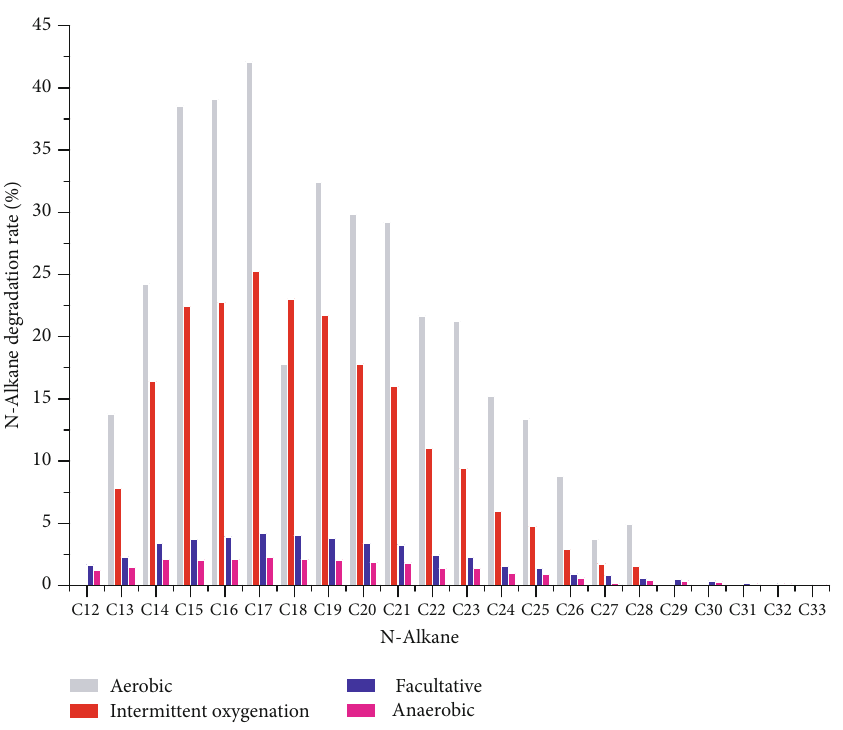
Figure 2: Degradation of alkanes of di ff erent chain lengths in di ff erent cultures.